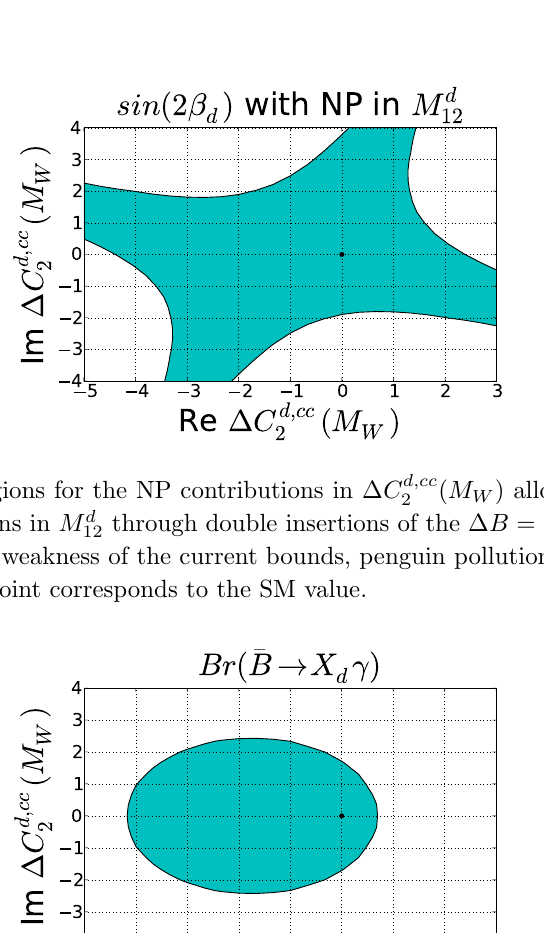
( M W ) allowed by the observable 2